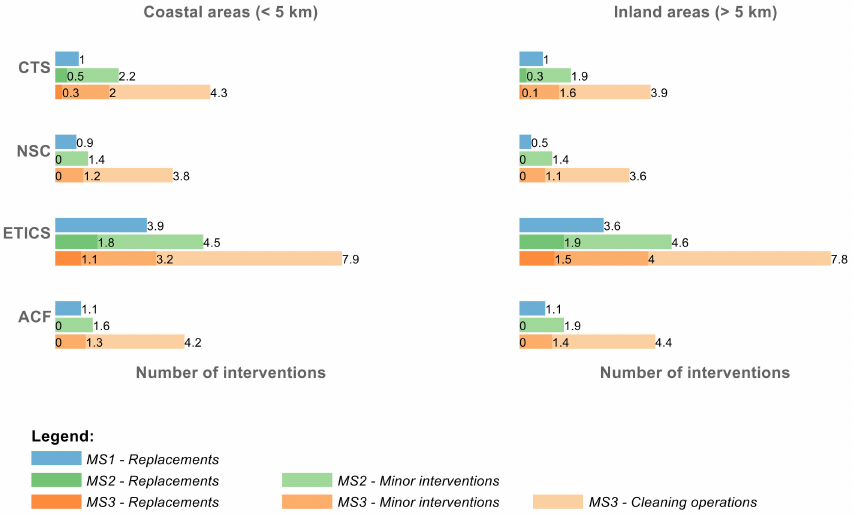
Figure 11. Comparison of the number of interventions according to distance from the sea for a time horizon of 80